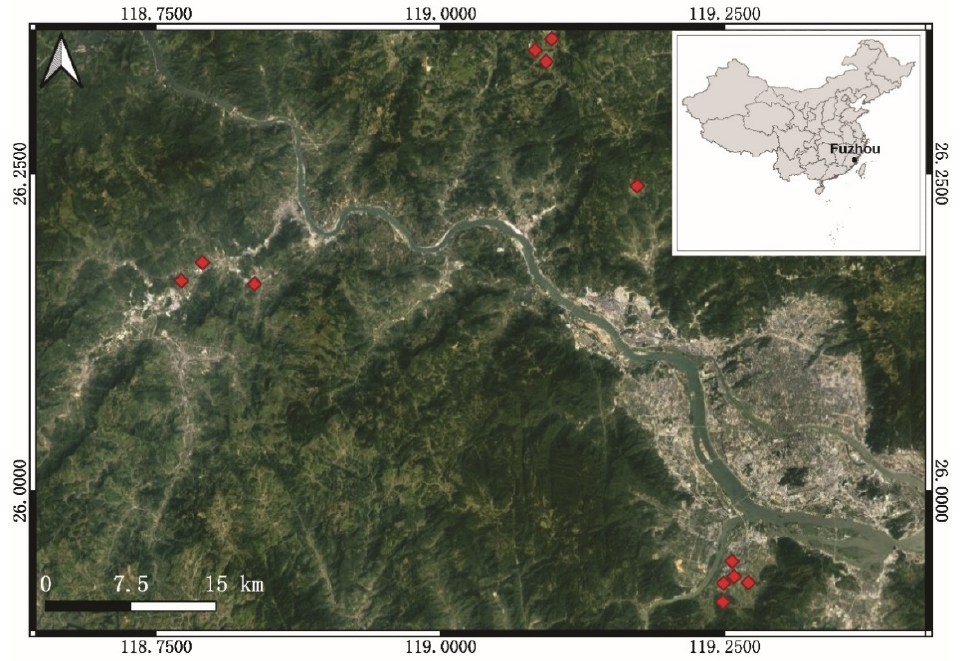
Figure 1. Geographical mapping of sampling sites in the region of Fuzhou city using QGIS. China map (white background in the upper right corner) was drawn using R software